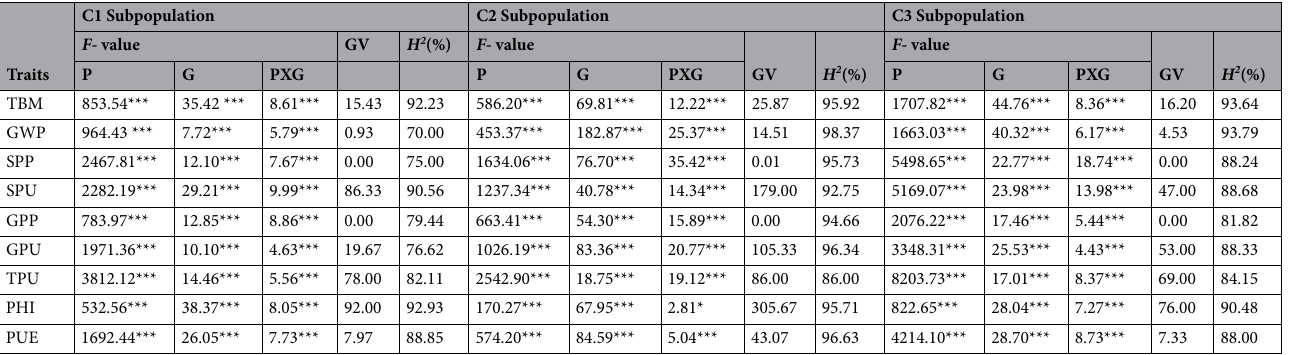
Table 3. ANOVA, genetic variance (GV) and broad sense heritability ( H 2 ) for P use efficiency related traits recorded in three subpopulations (C1, C2 and C3), obtained from 82 bread wheat accessions, grown under sufficient (42.2 mg P kg −1 soil) and low (2.67 mg P kg −1 soil) phosphorus soil. The pooled data over two years (2016 and 2017) was used for analysis. Abbreviations: TBM, total biomass plant −1 ; GWP, grain weight plant −1 ; SPP, shoot P percentage; SPU, shoot P uptake; GPP, grain P percentage; GPU, grain P uptake; TPU, total P uptake; PHI, P harvest index; PUE, P use efficiency. * P < .05; ** P < .01, *** P < .001; n.s., non-significant; P – phosphorus; G – accession; PXG – interaction between P and G.